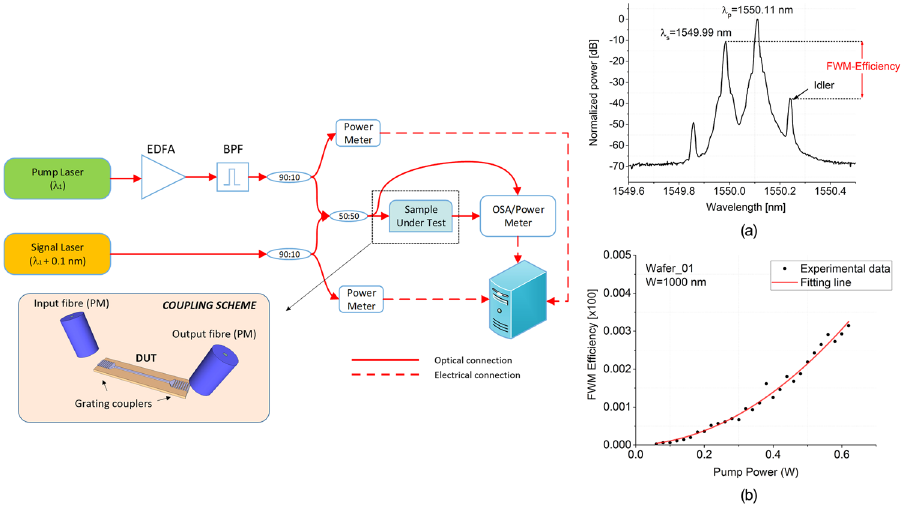
Figure 5. CW-FWM experimental set-up; BPF: Band Pass Filter. ( a ): example of CW-FWM spectrum recorded at the output of the waveguide (Wafer_02, W = 1000 nm, P p = 320 mW); ( b ): example of FWM-efficiency curve versus optical power used to calculate the Re{ γ } coefficients (Wafer_01, W = 1000